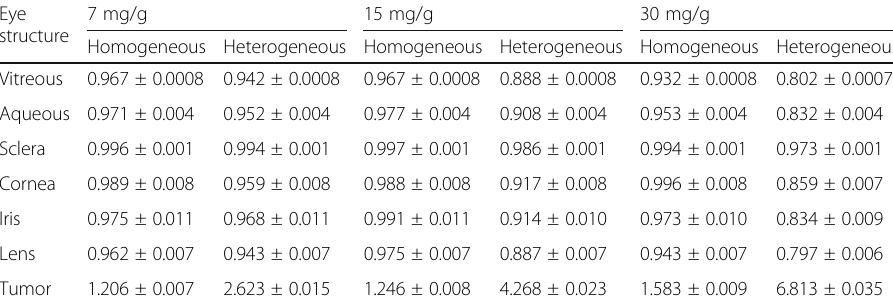
Table 3 The values of DEF calculated in different structures of the eye including a tumor loaded with 50 nm GNPs with concentrations of 7, 15, and 30 mg/g for homogeneous and heterogeneous models. The last row presents the average DEFs calculated in the nuclei of the tumor Eye 7 mg/g 15 structure